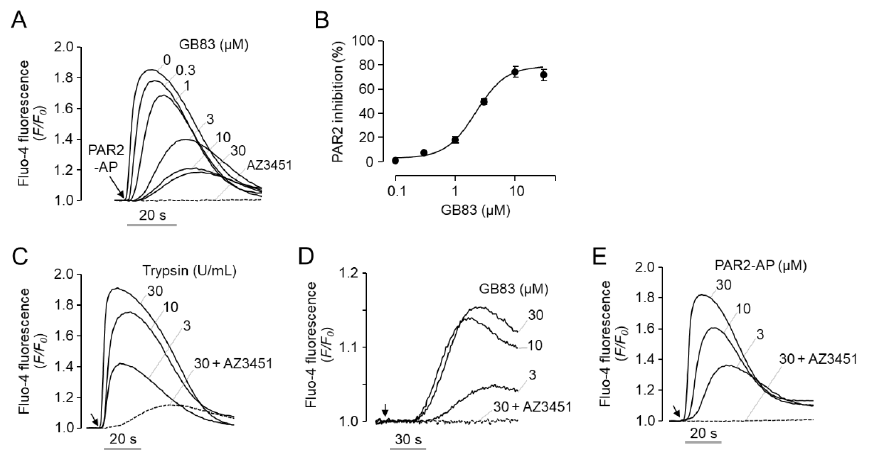
Figure 1. Effect of GB83 on PAR-2-mediated increase in intracellular calcium levels in HT-29 cells. ( A ) Inhibitory effect of GB83 on PAR2-mediated intracellular calcium increase. HT-29 cells were pre-